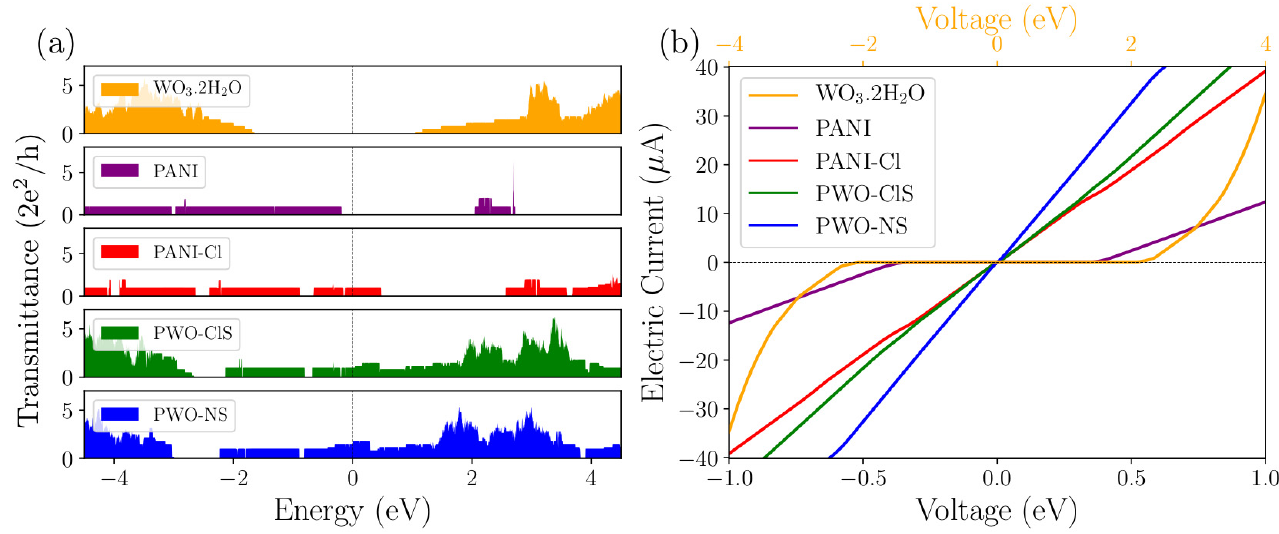
Figure 11. ( a ) Quantum transmittance spectrum of the proposed systems as a function of energy, considering EF = 0. The WO 3 ·2H 2 O and PANI models showed gap energy around the Fermi level of 2.6 eV and 2.2 eV, respectively. The other models presented conducting behavior in terms of electronic charge transport. ( b ) Electric current curves as a function of applied voltage for all proposed systems. The isolated systems WO 3 ·2H 2 O and PANI showed null electrical current in the ranges from 0.00 eV to 2.00 eV and from 0.00 eV to 0.37 eV, respectively, behaving as insulating materials. The doped PANI–Cl and the nanocomposite systems presented electrical current varying linearly as a function of the applied voltage, behaving as a metallic material.